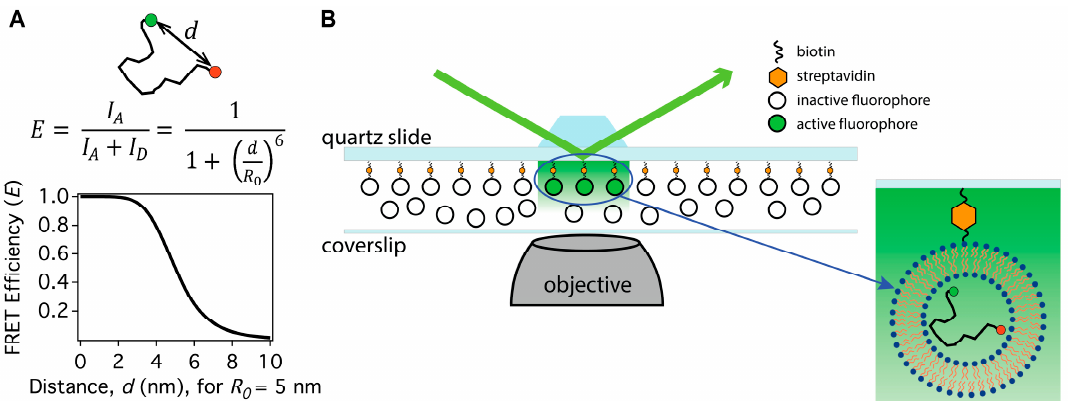
Figure 2. ( A ) The fluorescence (or Förster) resonance energy transfer (FRET) efficiency ( E ) is calculated by the relationship between donor ( D , green circle) and acceptor ( A , red circle) intensities ( I D and I A ). FRET efficiency has a strongly non-linear dependence (sixth power) on the distance between the donor and acceptor molecules ( d ) attached to an intrinsically disordered protein. R 0 is the Förster radius, which determines the length scale of the FRET coupling and is the value where the transfer efficiency is 50%. The donor and acceptor fluorescent dye properties determine R 0 , which usually is around 4–7 nm. ( B ) A schematic of prism-type total internal reflection (TIR) illumination for smFRET. The green arrow shows an incident laser beam that is totally internally reflected at the quartz-water interface of a fluidic channel, producing an evanescent wave that excites fluorophores near the surface. The zoomed detail shows an IDP labeled with a D–A pair that is encapsulated in a liposome (not to scale). The liposome is attached to the quartz surface via a biotin-streptavidin linkage while additional liposomes are shown in solution in the flowcell diagram.